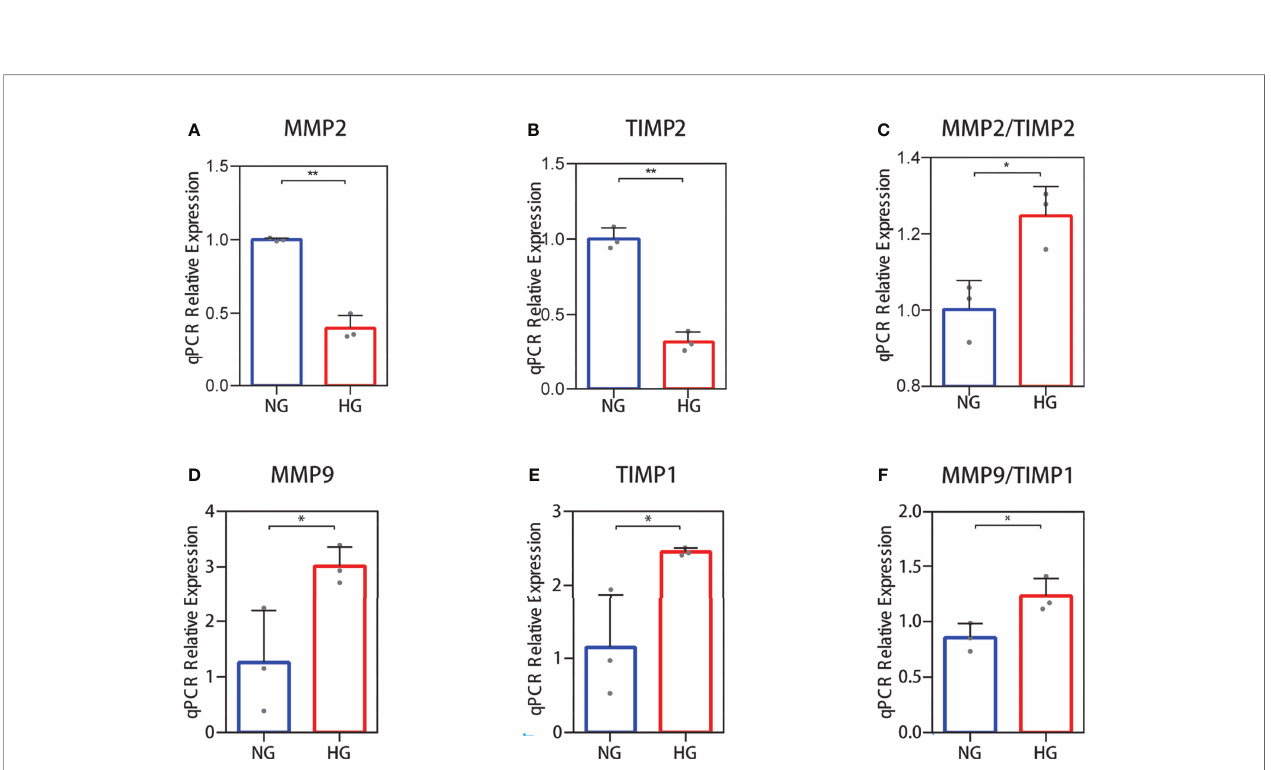
FIGURE 3 | RT ‐ qPCR validation of the MMP-2/TIMP-2 and MMP-9/TIMP-1 ratio in high glucose-treated HDFs. (A – C) The expression of MMP-2 and TIMP-2 mRNA in HDFs and the MMP-2/TIMP-2 ratio. (D – F) MMP-9 and TIMP-1 mRNA expression in HDFs and the MMP-9/TIMP-1 ratio. The independent experiment was repeated three times. The results are provided as the means ± SEM, * p < 0.05, ** p < 0.01 compared with the